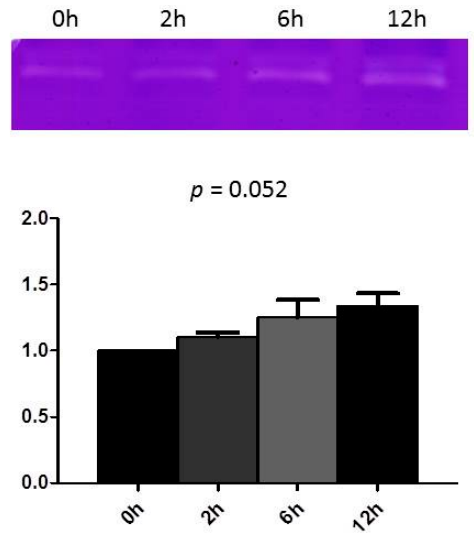
Figure 2. Tachypacing of HL-1 induces MMP9 secretion. HL-1 cells were subjected to 4 Hz pacing for the indicated times, the secretion of MMP9 protein in collected medium was evaluated by gelatin zymography as described in Methods. ( Bottom ) The relative expression levels of MMP9 were quantified by densitometry and normalized to the control level, which was set at 1.0. Each value represents the mean ± SE of four independent experiments. p value: Dose–response relationships analyzed using one-way ANOVA with linear trend test.